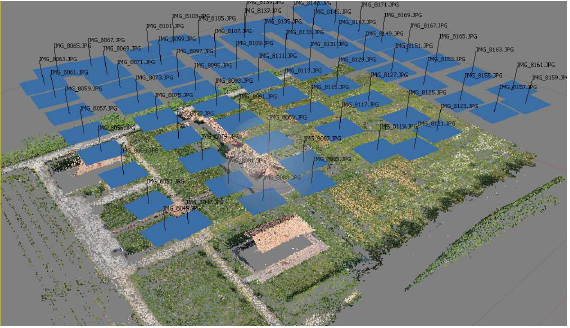
Figure 7. Flight plan and camera positions.